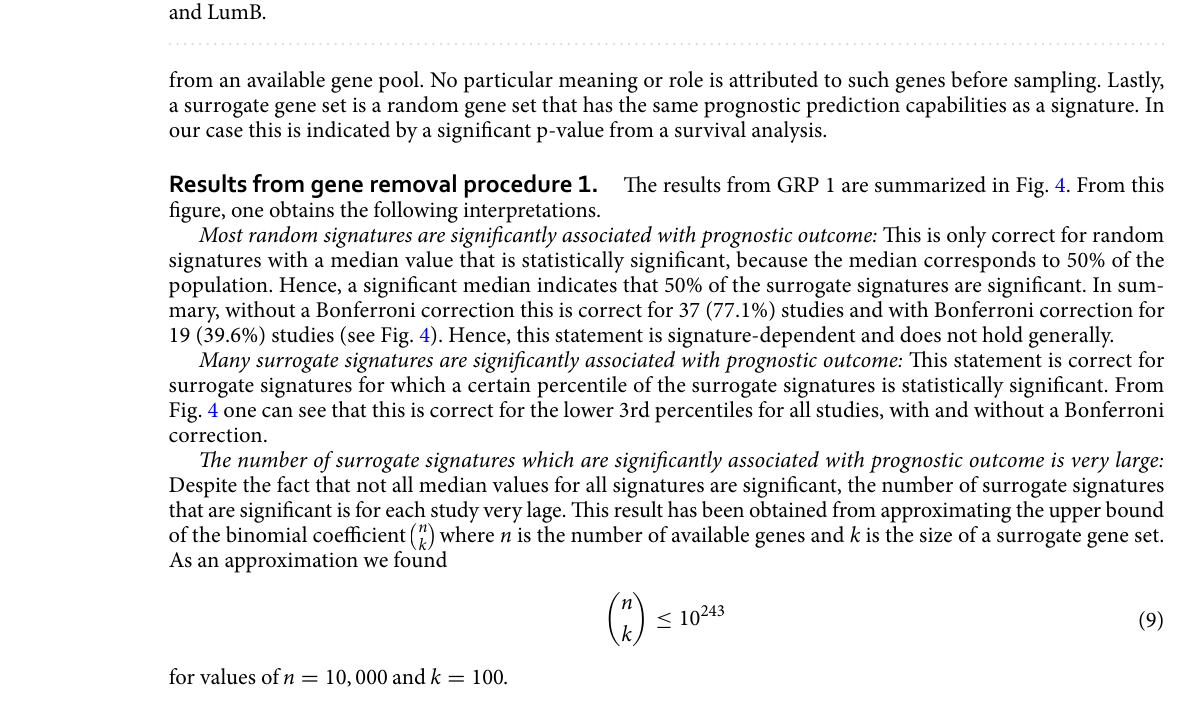
Figure 8. Results for gene removal procedure 2 and SWE data similar to Fig. 6. Patient samples contain LumA and